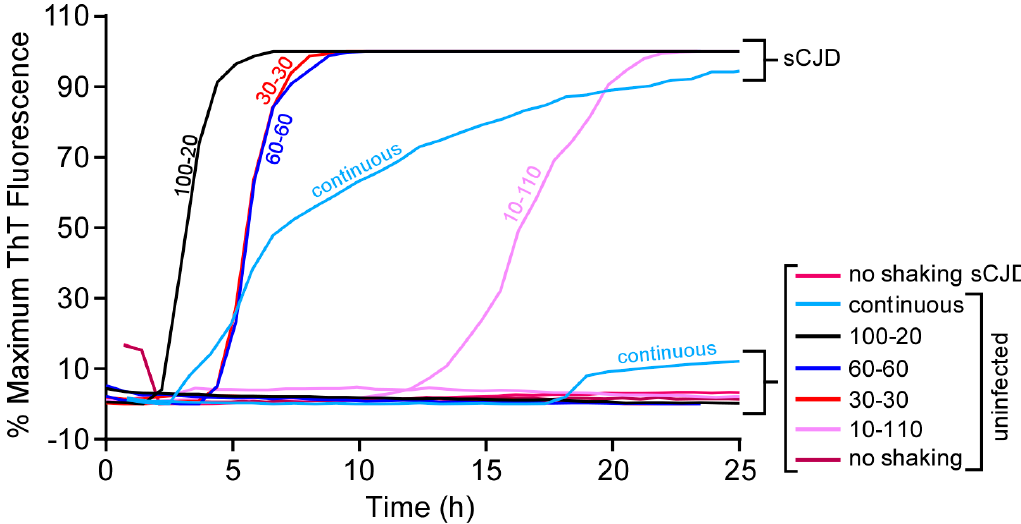
Figure 5. Effect of shaking conditions on RT-QuIC amplification kinetics. Reactions were seeded with either 2 μ L of 1 × 10 − 7 sCJD or Alzheimer diseased brain tissue dilutions and incubated at 42 °C. Each trace represents the averaged normalized % maximum ThT signal ( y -axis) of four replicate wells plotted as a function of time ( x -axis). Human rPrP Sen (23–231) was used as the substrate with a final NaCl concentration of 130 mM. The reactions were either continuously shaken (light blue), or subjected to cycles of shake and rest of variable duration (100, 60, 30, 10 s shake in combination with 20, 60, 30 or 110 s rest, black, royal blue, bright red and purple, respectively). Reactions that were not subjected to any shaking (dark red) were also examined.